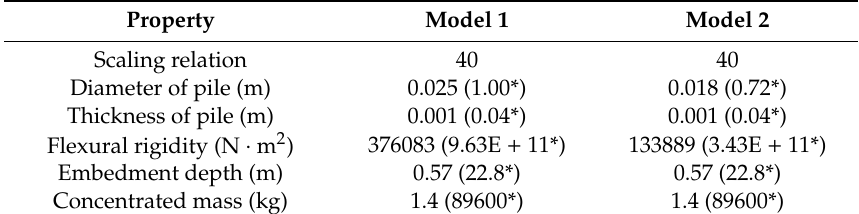
Table 3. Properties of the model piles.